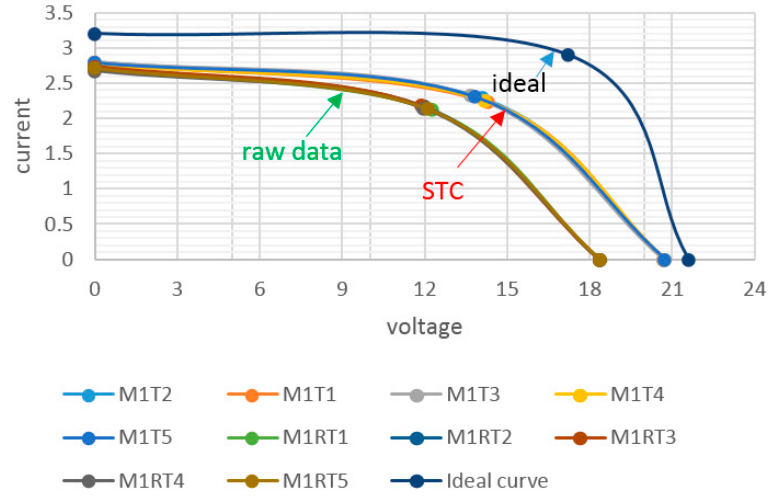
Figure 8. I-V curves of Module 1 to test for repeatability.